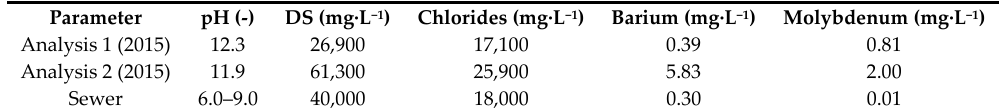
Table 1. Selected parameters—analyses of soggy sediments in the retention tank compared to values specified in the sewerage